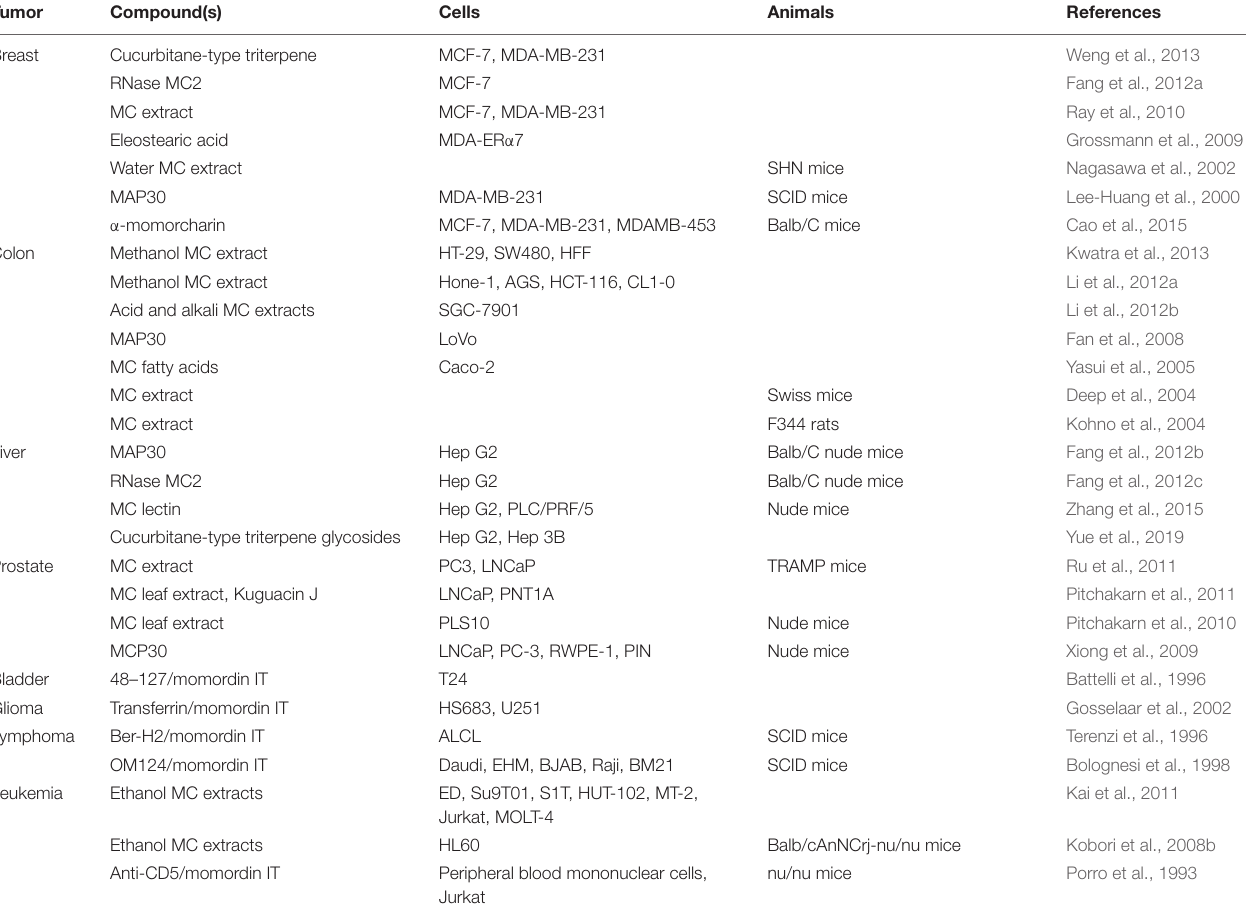
TABLE 2 | Main anti-tumoral studies carried out in vitro and in vivo with MC